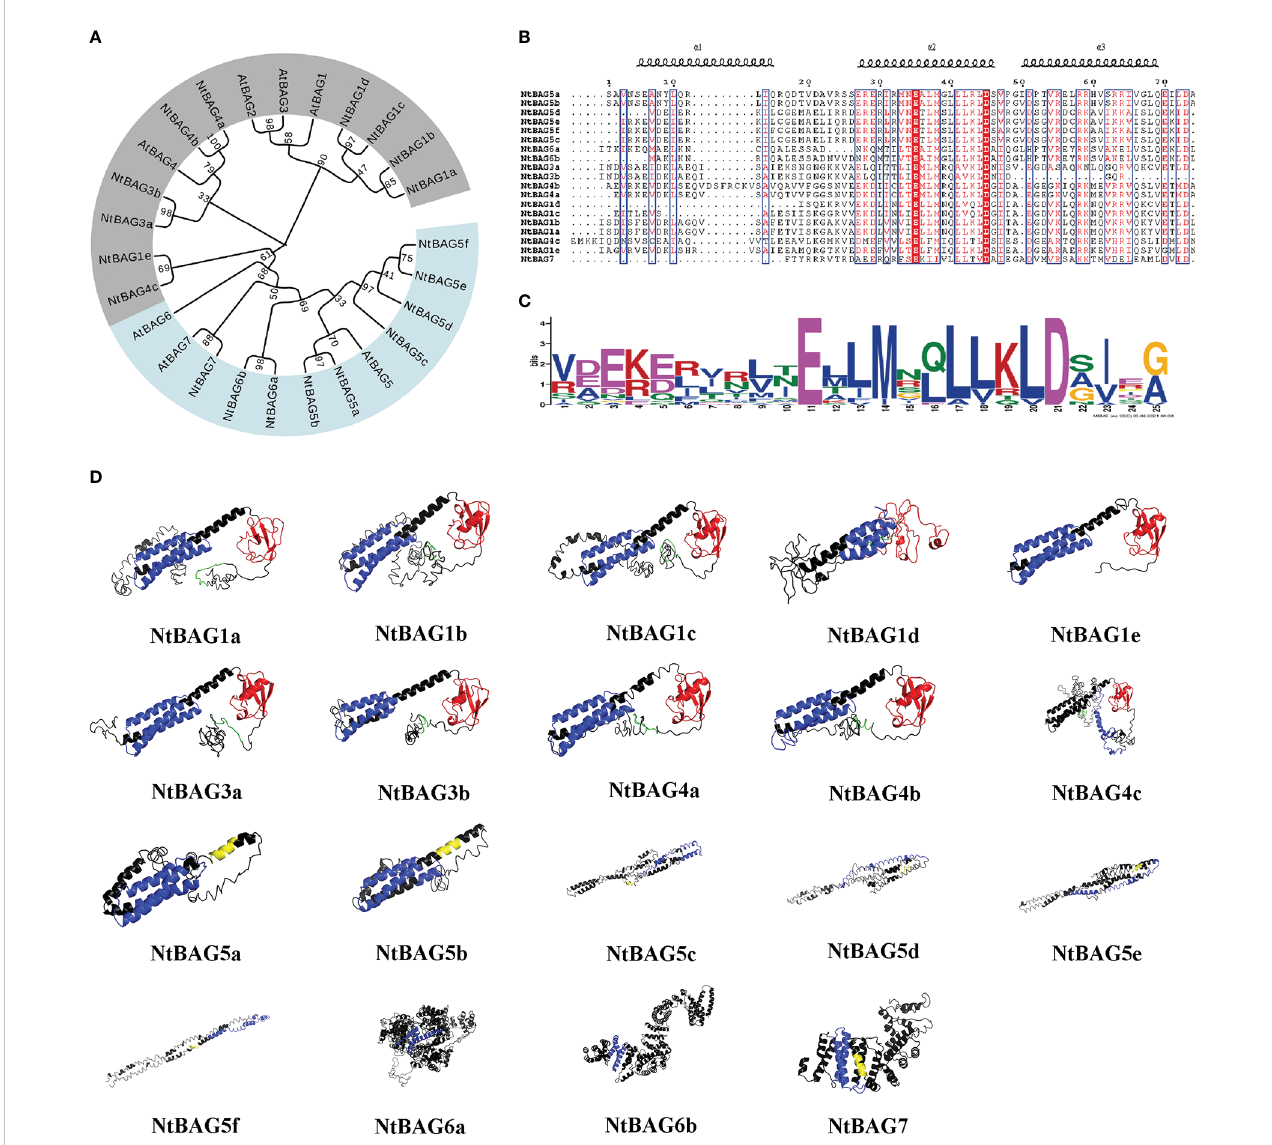
FIGURE 1 Phylogenetic and three-dimensional structure analysis of the NtBAG proteins. (A) The evolutionary history was inferred using the maximum likelihood method based on the Poisson correction model. The bootstrap consensus tree inferred from 1,000 replicates is taken to represent the evolutionary history of the analyzed taxa. Branches corresponding to partitions reproduced in less than 50% of bootstrap replicates are collapsed. Initial trees for the heuristic search were obtained automatically by applying neighbor-joining and BioNJ algorithms to a matrix of pairwise distances estimated using a JTT model, and then selecting the topology with the superior log likelihood value. The analysis involved 86 amino acid sequences. All positions containing gaps and missing data were eliminated. There were a total of 66 positions in the fi nal dataset. Evolutionary analyses were conducted in MEGA7. (B) Alignment of the domains conserved within the BAG protein family. The locations of the three helices are shown above the alignment. (C) A motif conserved among the BAG family proteins. The consensus sequences were displayed using Weblogo. (D) Prediction of three-dimensional structure of NtBAG proteins. The BDs of the NtBAG proteins are depicted in blue, the ubiquitin domain (UBD) is depicted in red, and the IQ motif is depicted in yellow. A conserved sequence motif of 12 amino acids (ExRPGG[ML/VV]QxR) is depicted in